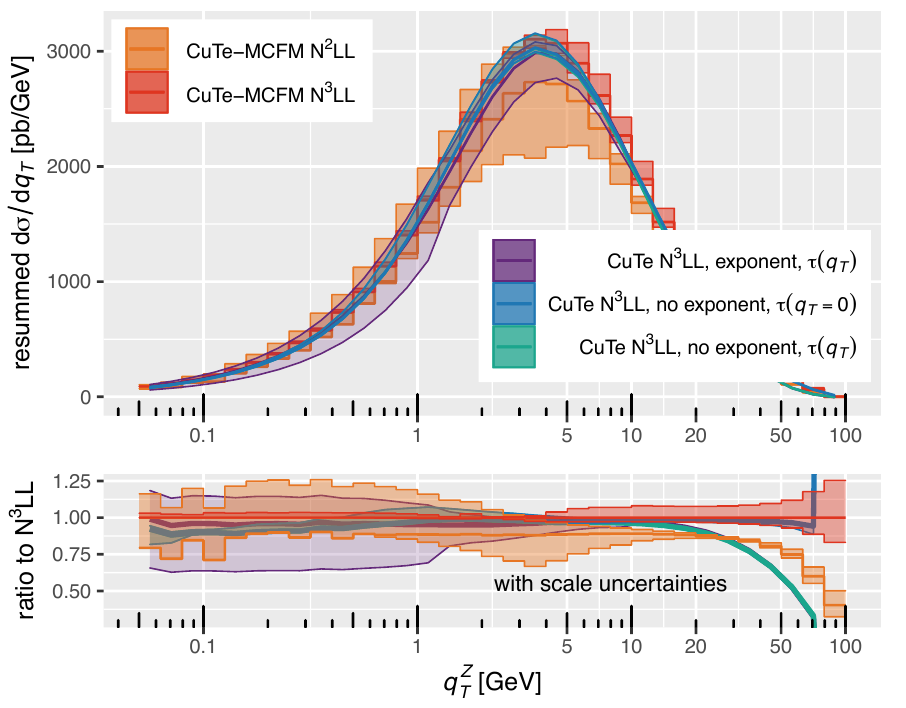
Figure 6. Resummed results without matching for inclusive Z production at 13 TeV obtained using CuTe-MCFM and CuTe at different logarithmic orders. For CuTe we show results in two schemes: expanded in the exponent or on the level of the cross section. We furthermore present results with two different treatments of power-suppressed terms in the phase space related to the choice of τ ( q T ) , see text. The shaded band displays scale uncertainties. The bottom panel shows the ratio to the N 3 LL result in CuTe-MCFM .